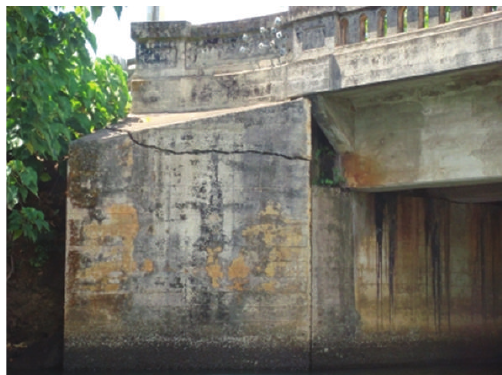
Figure 2: A field image taken under the over-crossing bridge of Wailua river, Kapaa, Hawaii, which shows a long crack on the bridge